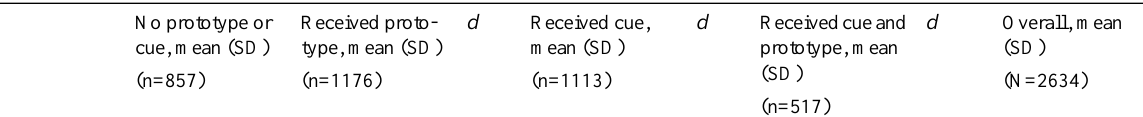
Table 3. Means and standard deviations (based on last observation carried forward) and effect size (Cohen’s d ) a for primary and secondary outcomes for baseline (T1), 1-month posttest (T2), and 6-month follow-up (T3) measurements, overall and per analysis